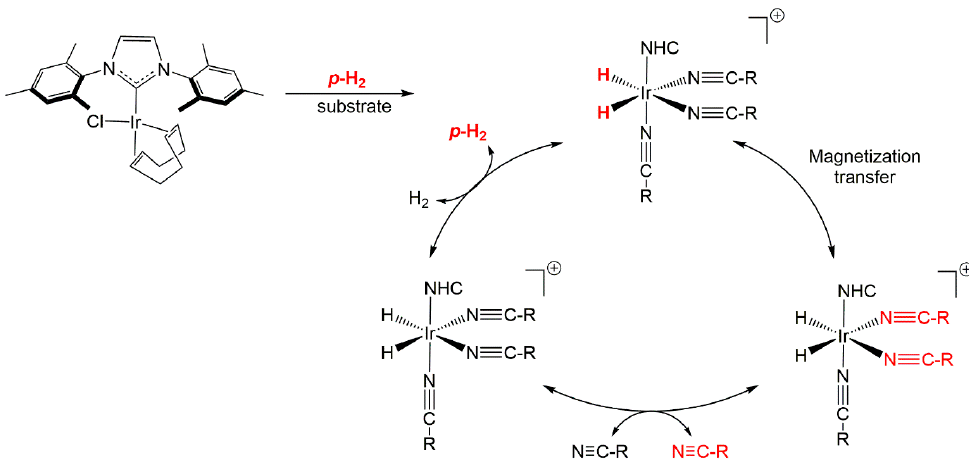
Figure 1. Hyperpolarization procedure of Signal Amplification by Reversible Exchange (SABRE) with nitrile compounds [12]. NHC is N -heterocyclic compounds.